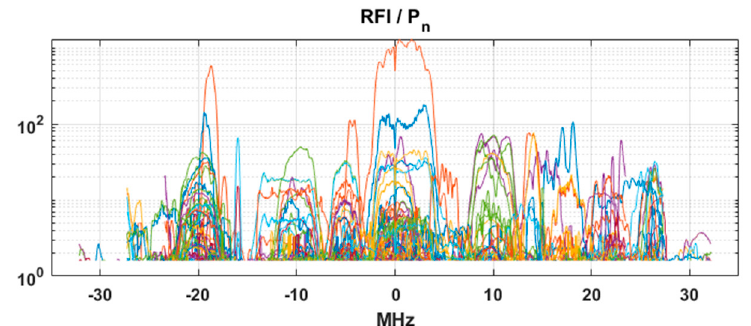
Figure A6. Stacking of all the RFI power spectra evaluated in Europe by Sentinel-1. Vertical axis is power, normalized to Sentinel-1 noise power spectrum.